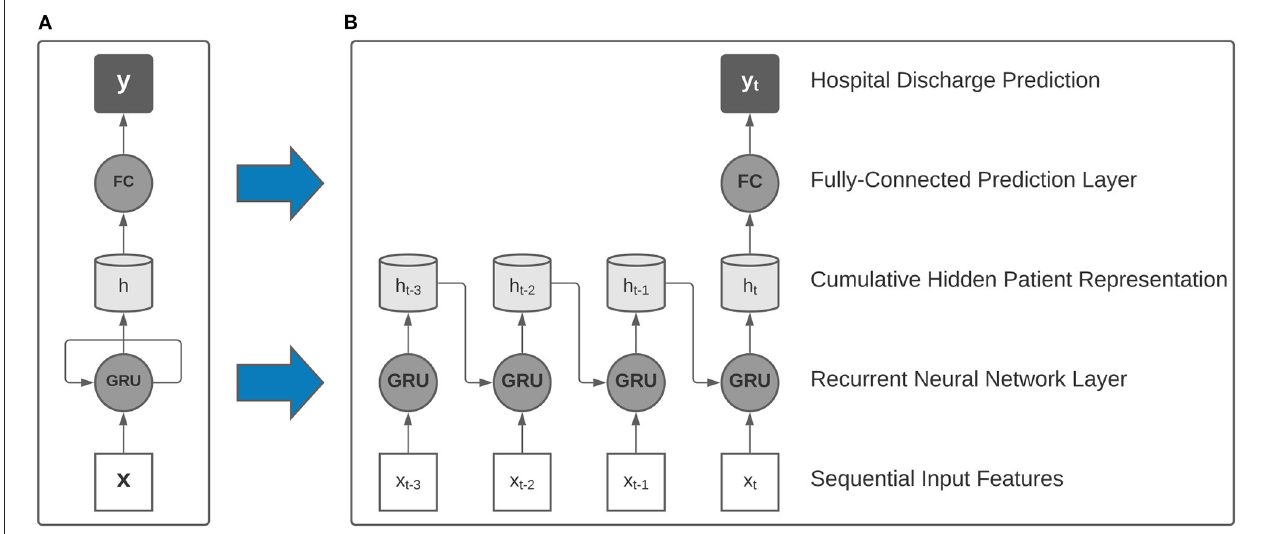
FIGURE 2 | Collapsed (A) and expanded (B) view of a single-layer recurrent neural network with gated recurrent units (GRU) used as building blocks in our model. After processing multi-resolution sequences of vital signs and activity sensor data, a final hospital discharge prediction was made using the final hidden